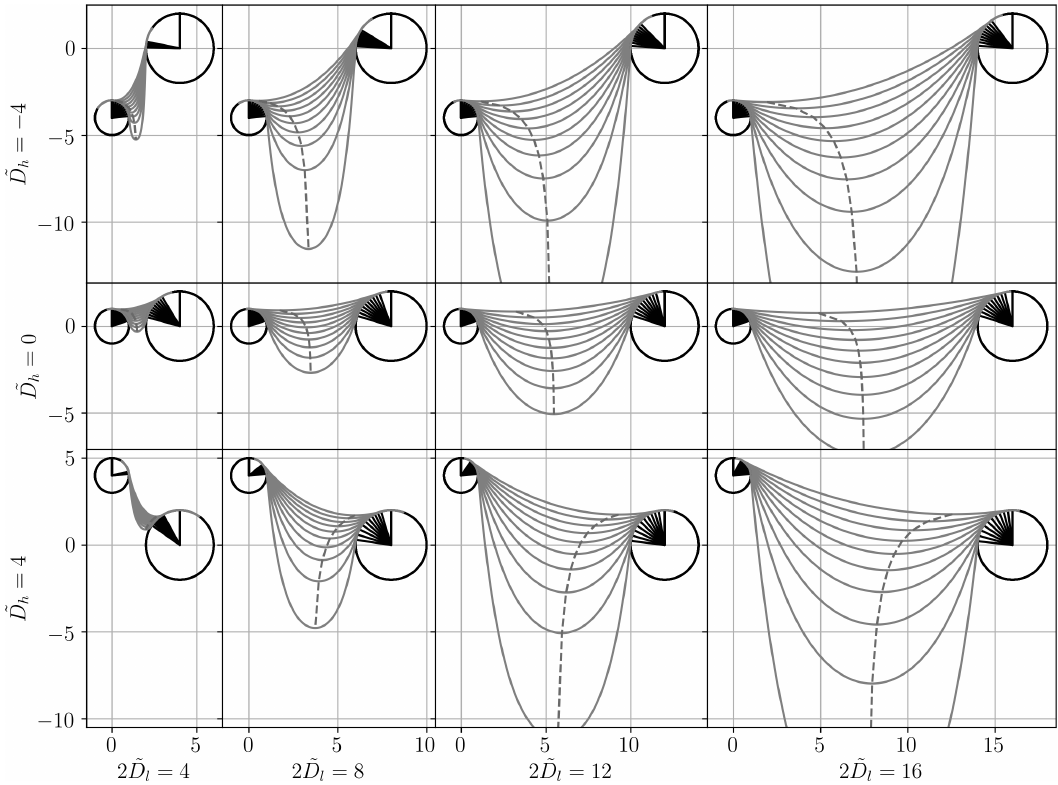
Figure 6. The shape of the moving thin-sheet materials between rolls when position of rolls